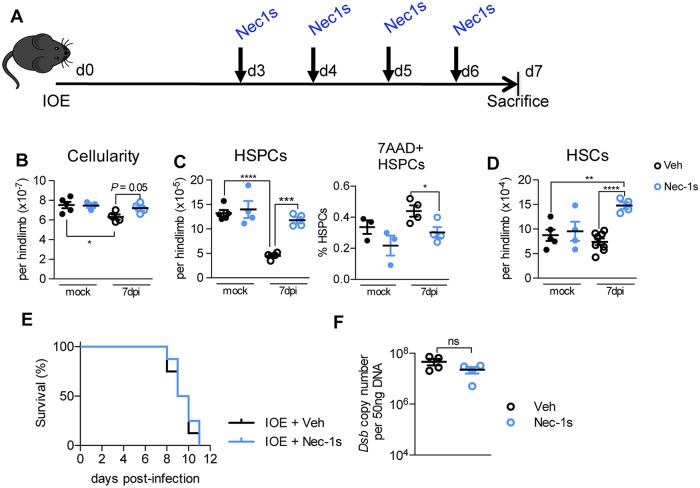
RIPK1 antagonism during infection rescues HSPCs and HSCs but does not impact bacterial burden or survival.(A) Schematic of IOE infection and treatment with Necrostatin 1 (Nec1s), which was administered twice/day. (B-D) BM cellularity (B), HSPCs (D) and HSCs (E) in vehicle (Veh)- or Nec1s-treated mock- or infected WT mice 7 d.p.i. n = 4–5 mice/group. *P < 0.05, **P < 0.005, ***P < 0.001, ****P < 0.0001. (E) Survival of IOE-infected WT mice treated with Veh or Nec-1s, as depicted in (A), n = 8 mice/group. (F) Bacterial burden in the spleen of Veh- and Nec-1s-treated IOE-infected WT mice at 7 d.p.i., represented as Dsb copy/50ng total DNA.